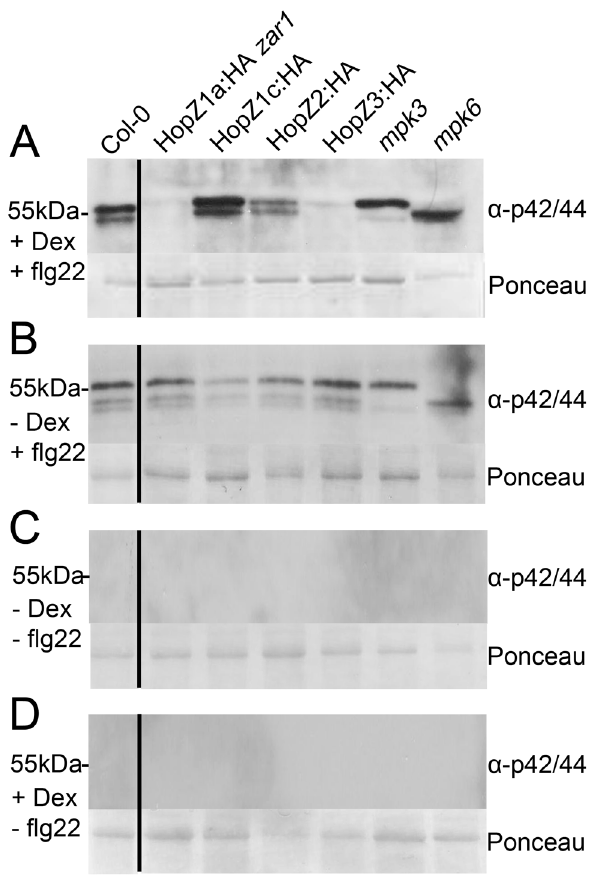
Fig. 5. HopZ family members differentially suppress MPK phosphorylation. Transgenic HopZ 11 day-old seedlings were induced with 30 m M dexamethasone or mock treated with water 24 hours prior to application of 1 m M flg22 and harvested 20 mins after flg22 application. 20 m g of seedling tissue was subjected to immunoblot analysis with phospho-specific p42/p44 MPK antibodies. mpk3 or mpk6 are mutants in one of the two MPKs that are phosphorylated. The Ponceau Red stained blot serves as the loading control. The following lines were tested: HopZ1a line 2D in zar1 , HopZ1c line 32A in Col-0, HopZ2 line 12B in Col-0, and HopZ3 line 21J in Col-0. The experiment was repeated three times with similar results. (A) + Dex + flg22 (B) 2 Dex + flg22 (C) 2 Dex 2 flg22 (D) + Dex 2